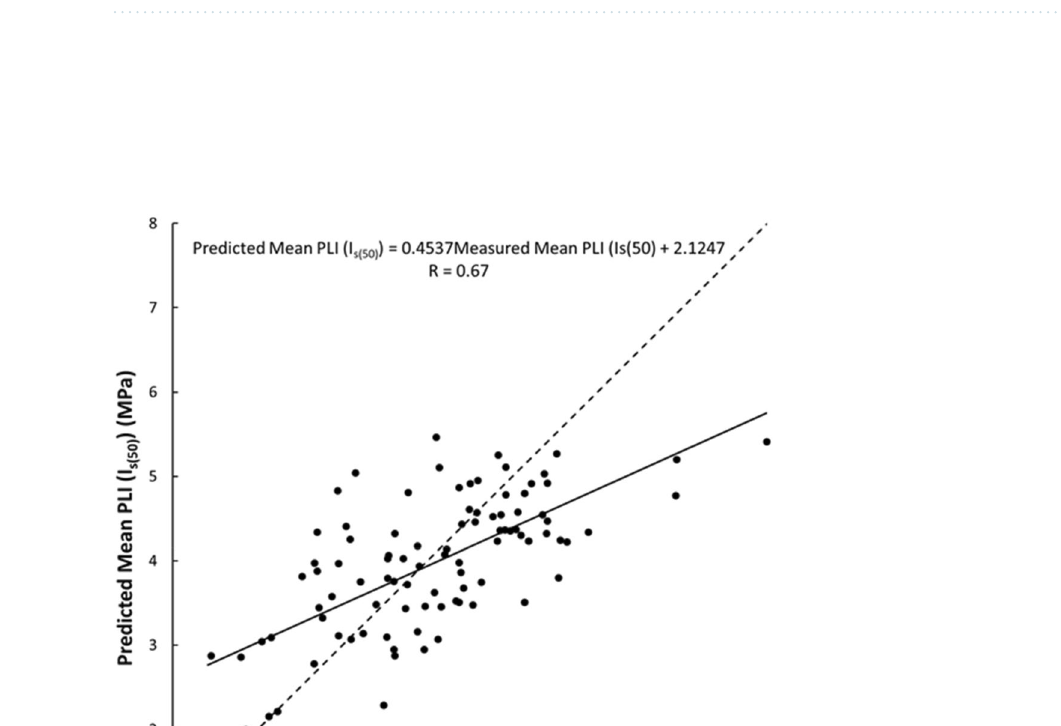
Figure 19. Cross-correlation of the measured and predicted values estimated from V p in terms of UCS values of limestone.